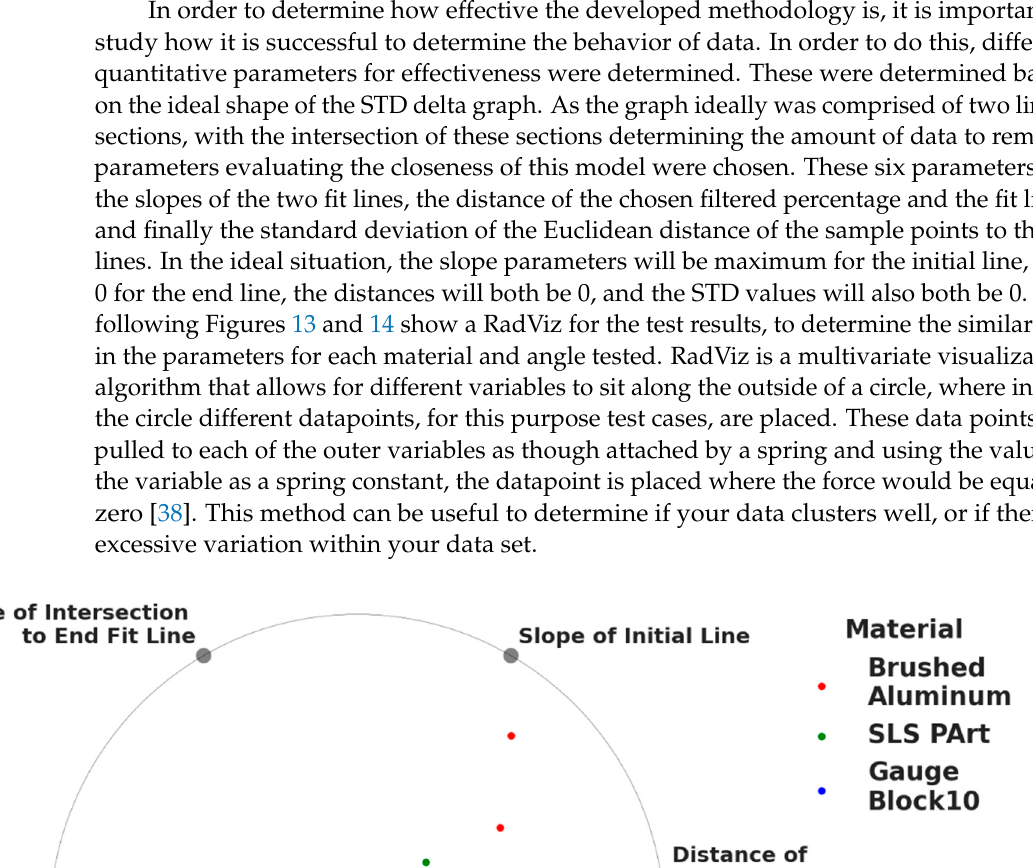
Figure 14. RadViz of parameters for each test, separated by angle. In these visualizations, clear clustering can be seen. In this visualization, clustering is indicative of the correlation between different parameters. If for multiple, or many tests, the results cluster to one section of the circle, the items closest have the greatest effect on the result of the test. For all but the outliers, there was a very clear pull to both the distance of intersection to the initial line fit and to the STD of the end line. This means these two